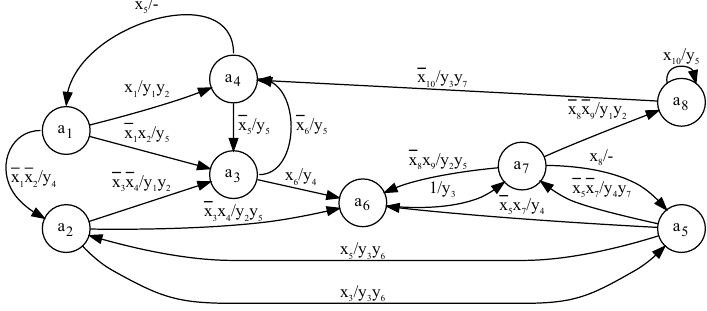
Figure 5. The state transition graph of Mealy FSM S 0